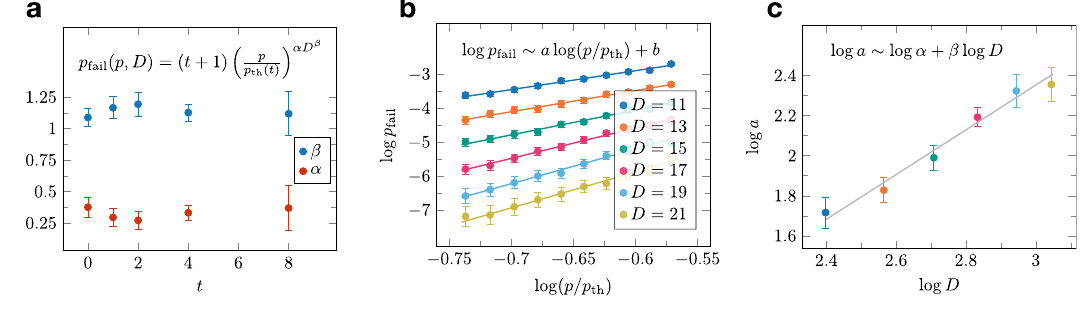
Fig.9|Subthresholdbehaviorofthesingle-shotMWPMdecoder.a Weestimate the parameters α ( t ) and β ( t ) of the ansatz in Eq. (20) for the logical failure prob- ability. We fi nd that both α ( t ) and β ( t ) are stable across the range of simulated valuesof t . b , c Anillustrationofthe fi ttingprocedurefor t =8. b Weplotlog p fail as